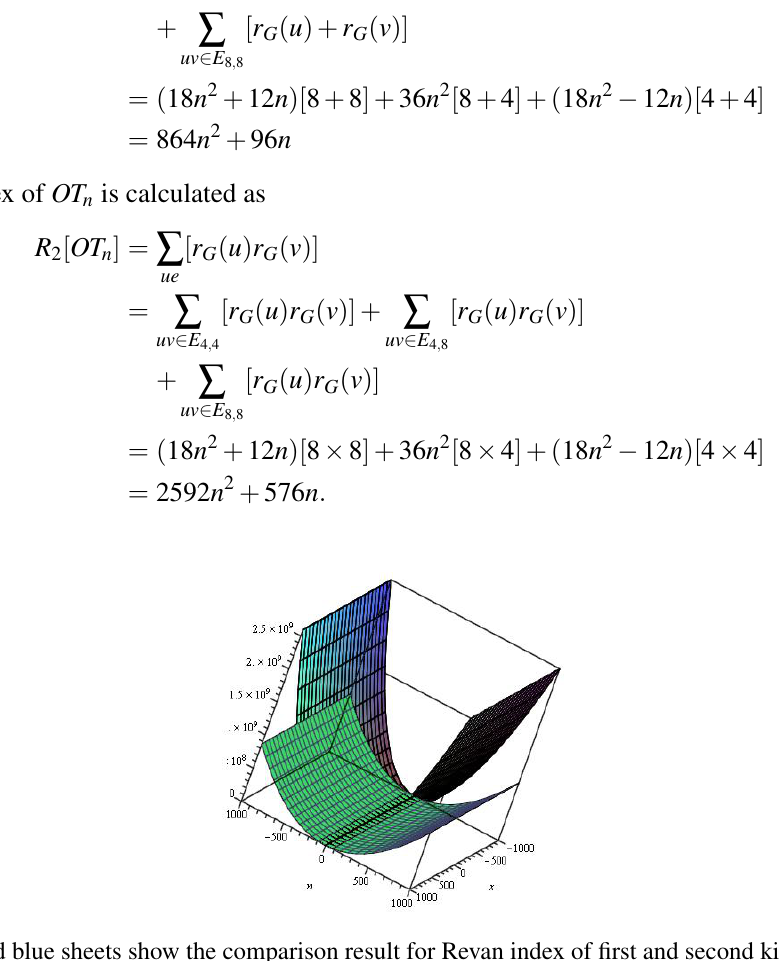
Fig. 2 The green and blue sheets show the comparison result for Revan index of first and second kind Octahedral network OT n